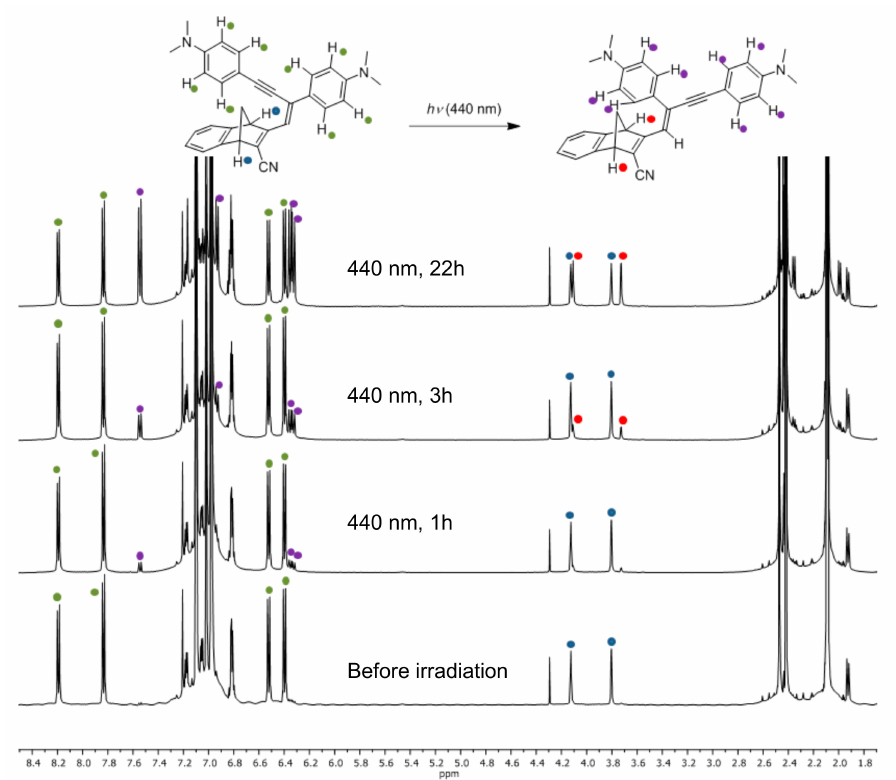
Figure 5. 1 H-NMR Spectra (toluene- d 8 , 500 MHz) of 9 recorded after various times of irradiation (440